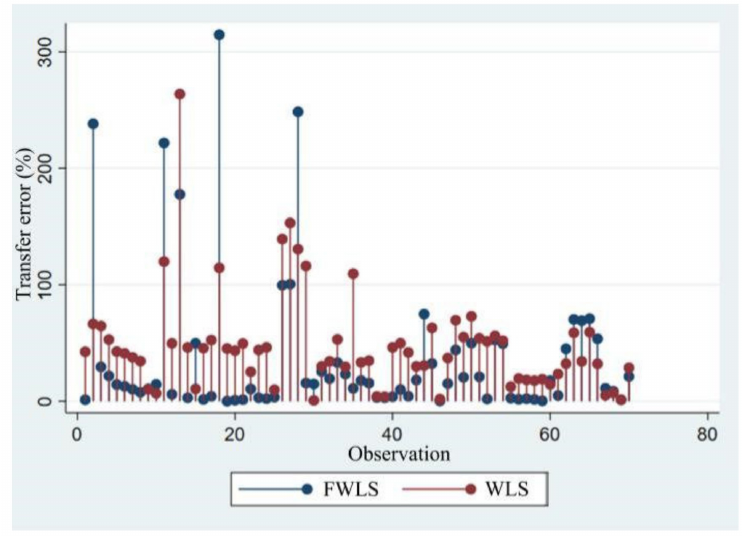
Figure 4. FWLS and WLS transfer